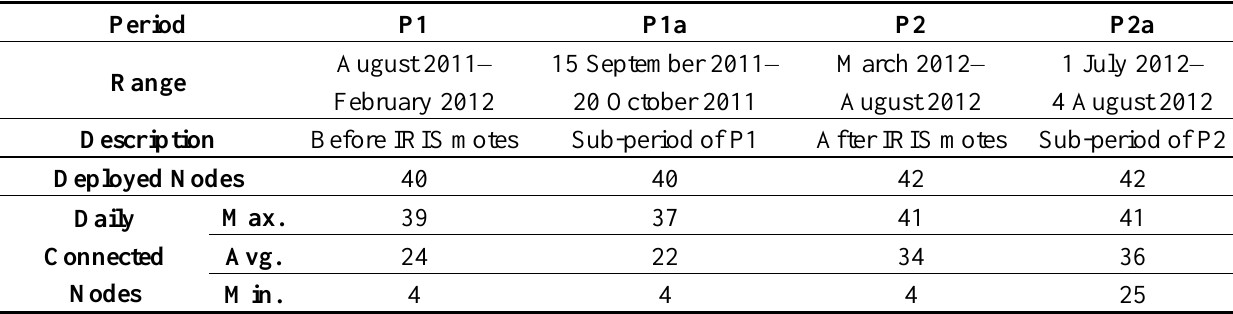
Table 3. Definitions of the two XMesh evaluation periods and the two sub-periods, including time range, number of deployed nodes, and daily connected nodes (maximum, average, and